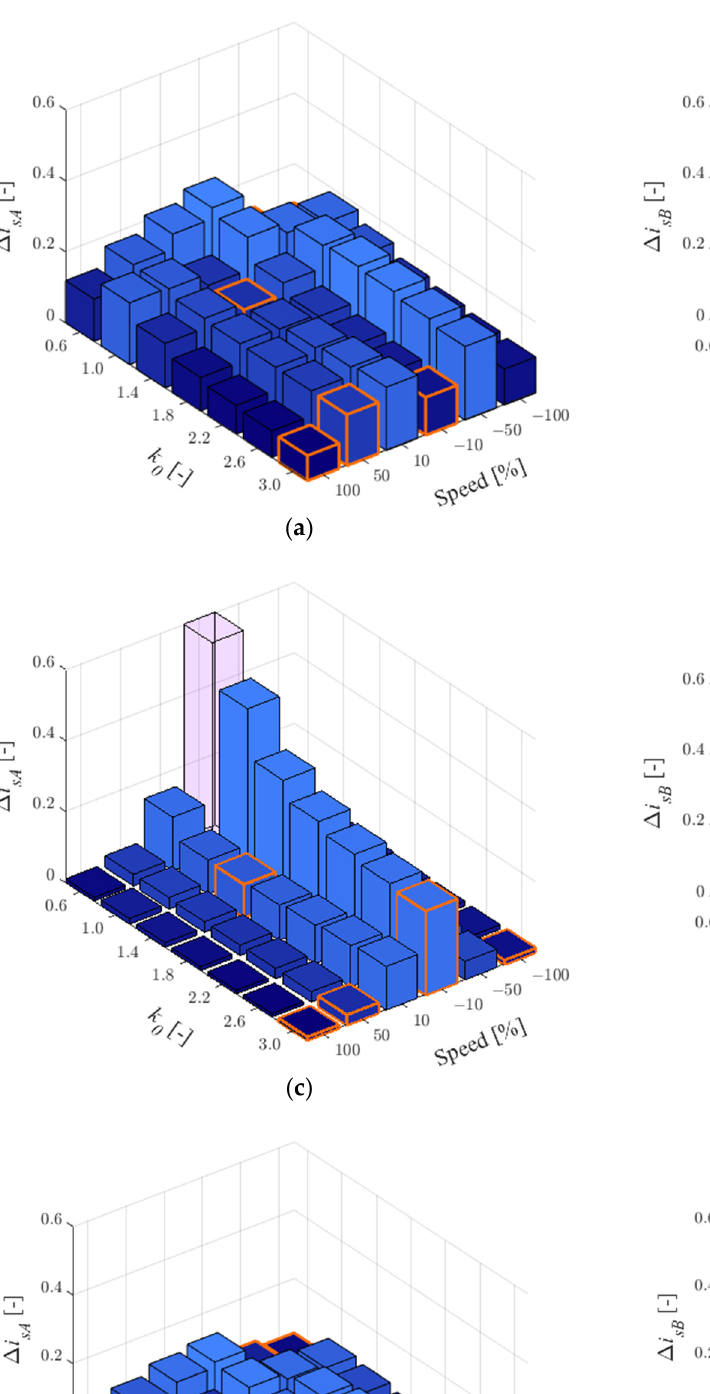
Figure 3. RMSE values for stator currents in phase A ( a , c , e ) and B ( b , d , f ) for r rIM = 1.5 r rN ( a , b ), r sIM =